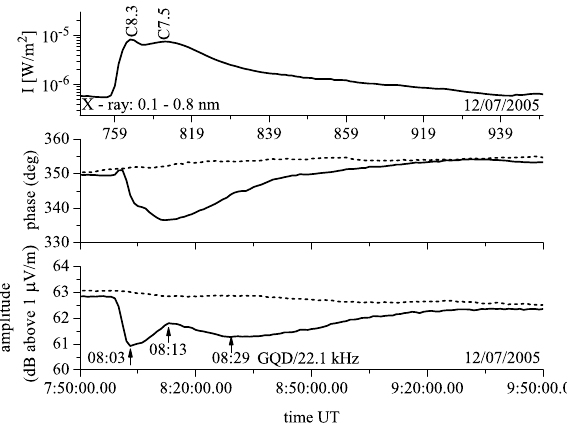
Fig. 3. Time variation of X-ray irradiance, GQD signal phase and amplitude during C8.3 (08:03UT) and C7.5 (08:12UT) events on 12 July 2005 – solid lines. Extrema indicated by arrows and the cor- responding UT. Phase and amplitude on the quiet day 8 July 2005 – dashed